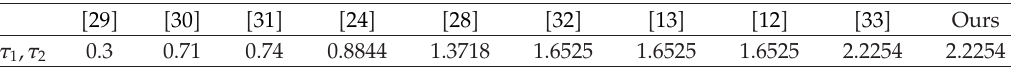
Table 2: Some comparison for allowable upper bounds on τ 1 (cid:2) Example 4.2 (cid:3)